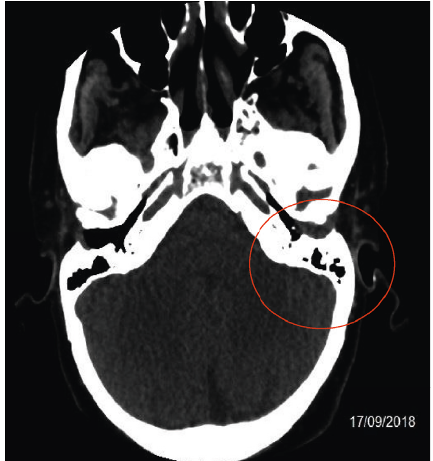
Figure 1: CT of the left ear without contrast medium.